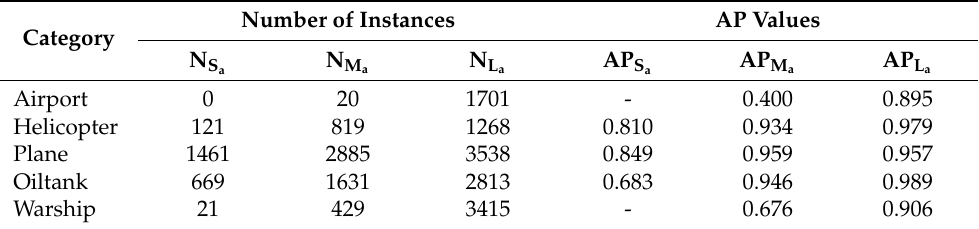
Table 3. The AP values of different object sizes on RSD-GOD testing dataset.